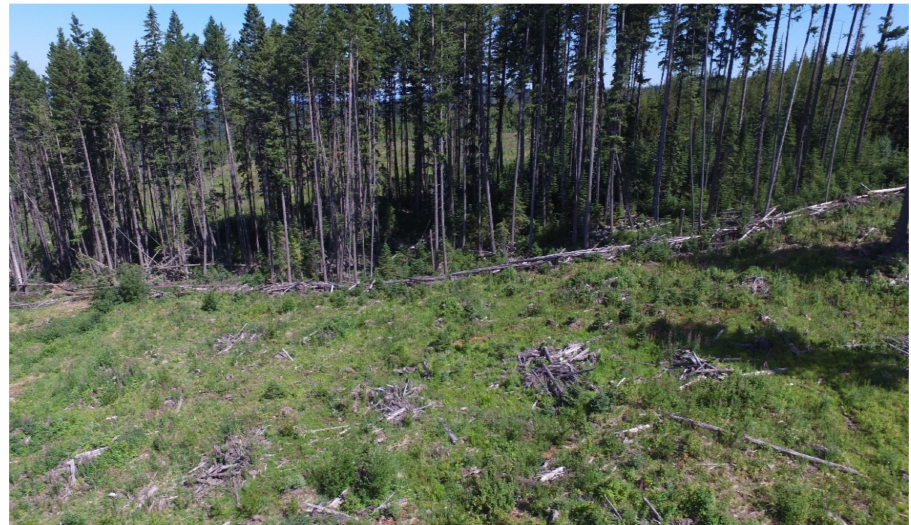
Figure 10. Linear windrow of woody debris to protect unlogged riparian area from cattle. (Photo by L. Zabek).